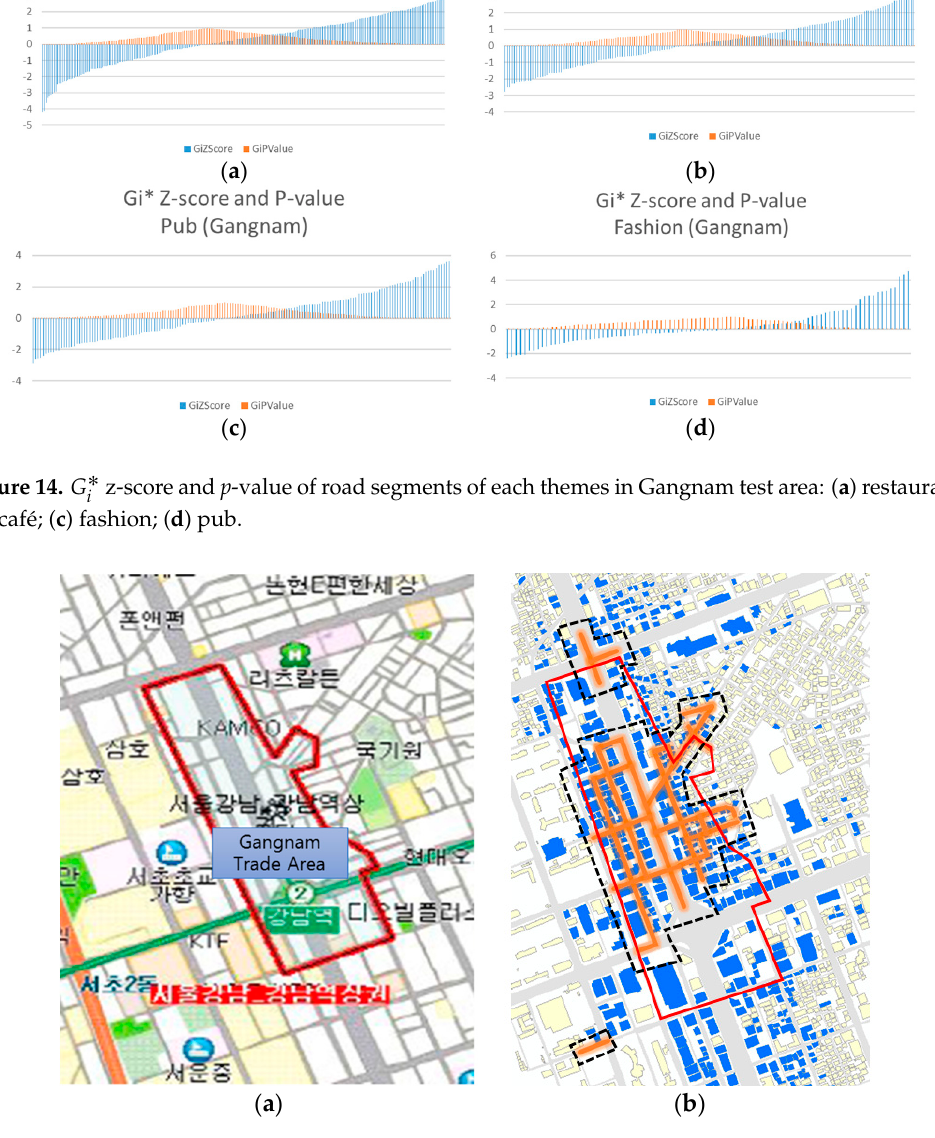
from the SBDC (red line) and sum of all the themed street clusters (dashed black line). Blue polygons